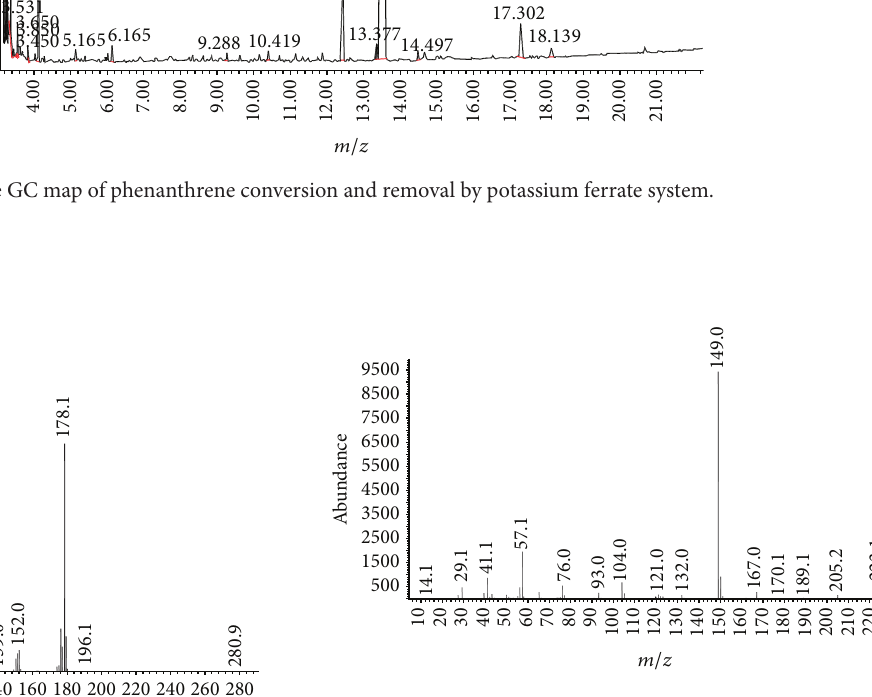
Figure 7: The mass spectrogram of 13.375